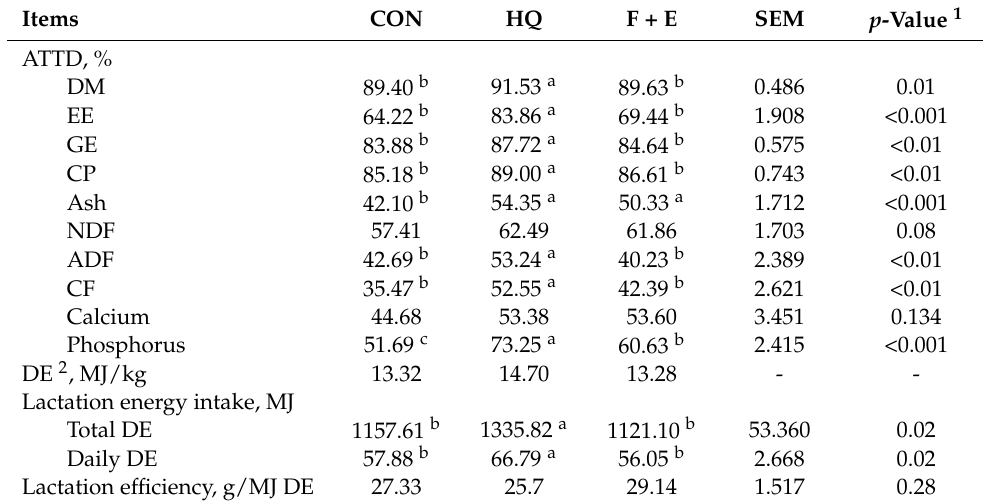
Table 4. Apparent total tract digestibility, sow energy intake and lactation efficiency of lactating